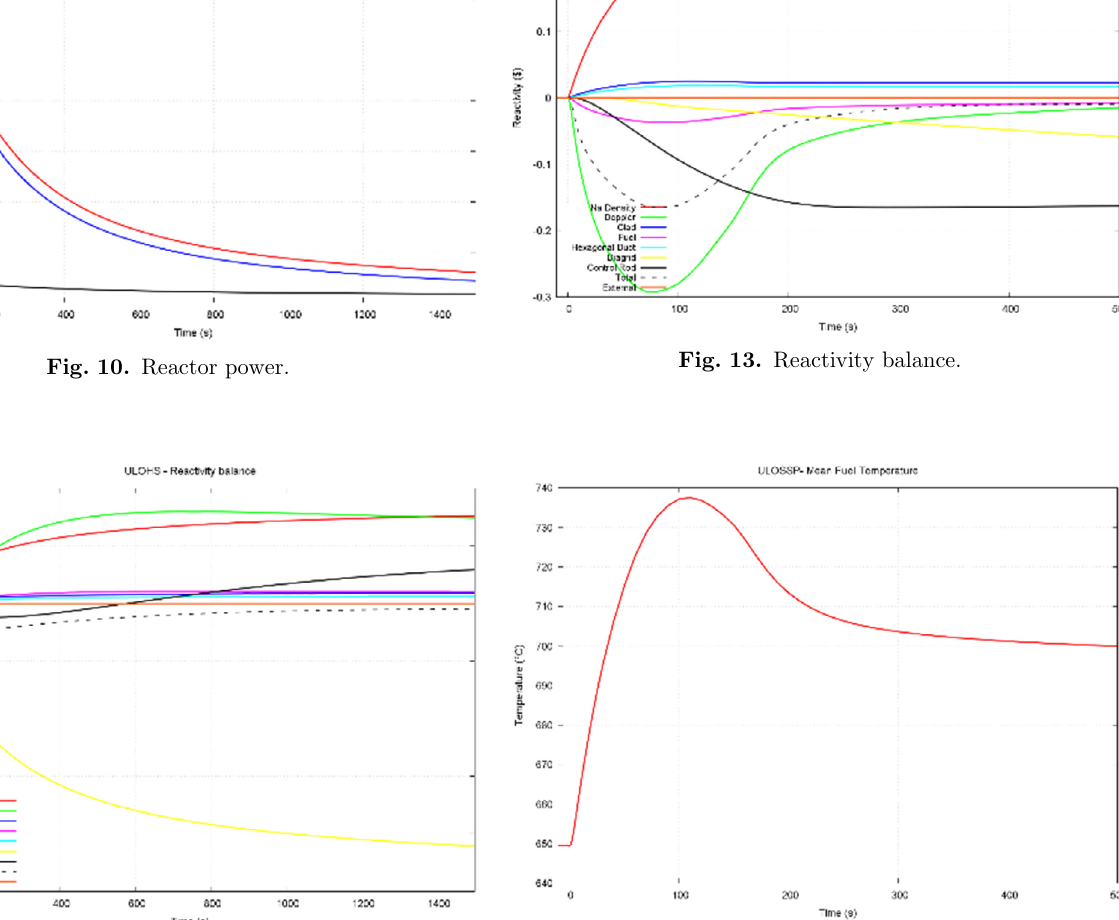
Fig. 11. Reactivity balance.